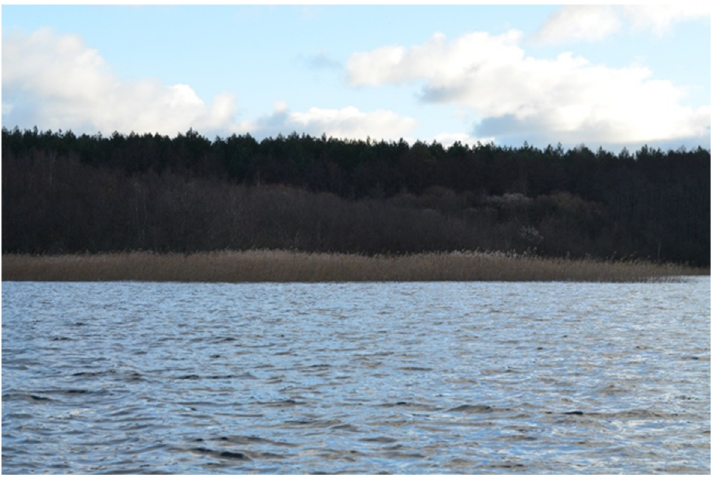
Figure 3. Reed bed on Domys ł awskie Lake (photo: Konrad Wrzecionkowski).